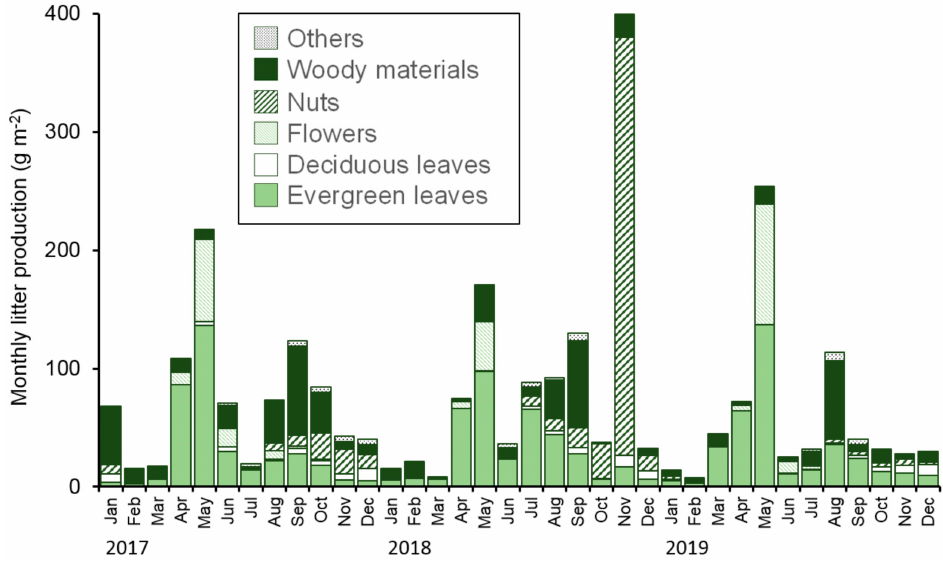
Figure 1. Monthly litter production (g m − 2 ) in a lucidophyllous forest dominated by C. cuspidata using nine litter traps for three years. Table 1. Interannual variation in NPP components in a lucidophyllous forest. Superscript letters represent significant differences ( p < 0.05) among the years based on one-way ANOVA followed by Tukey’s